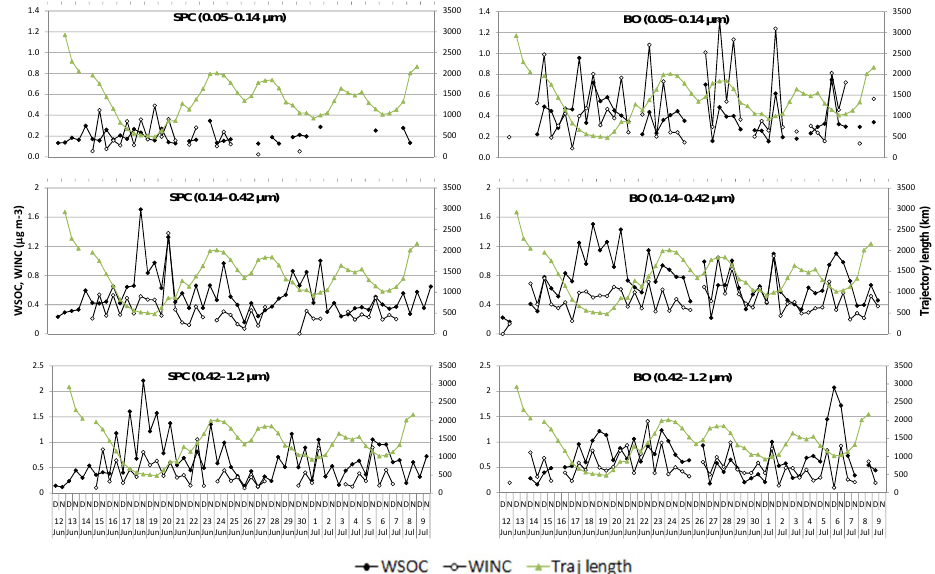
Figure 10. Time series of WSOC and WINC ( = TC − WSOC) concentrations in the size intervals: (1) 0.05–0.14µm, (2) 0.14–0.42µm and (3) 0.42–1.2µm. Four-day back-trajectory length is superimposed to each graph. Results for the urban (BO) and for the rural (SPC) station are shown.